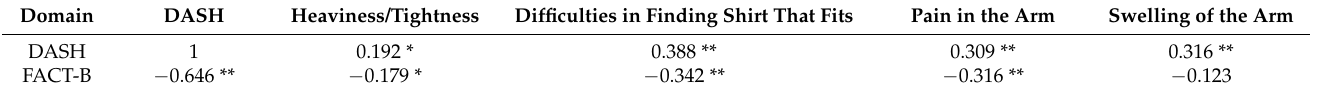
Table 2. Correlation between the FACT-B, DASH, and arm